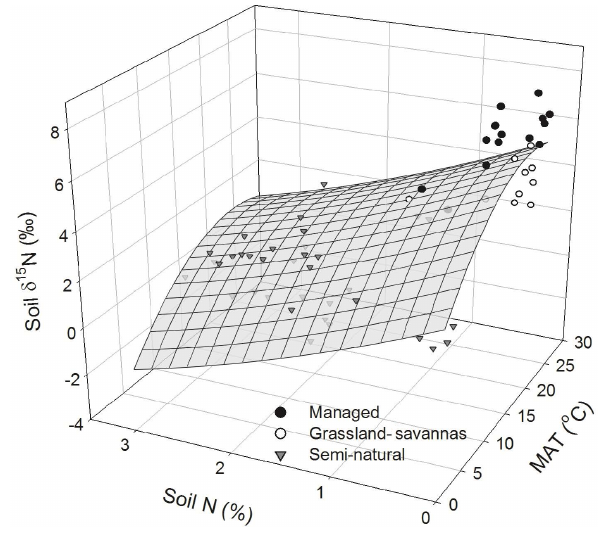
Figure 6. Measured and modelled soil δ 15 N values predicted as a function of soil N abundance and mean annual temperature (MAT). Data points are classified by generic land uses (i.e. in- tensively managed cropping sites, extensively managed grassland and savannas, and semi-natural ecosystems) observed along the el- evational and land-use gradient. The regression takes the follow- ing form: soil δ 15 N = 1 . 10 + 0 . 49 (MAT) − 1.86 (soil N) − 0.01 (MAT) 2 + 0 . 14 (soil N) 2 ; ( r 2 adj = 0 . 68, P < 0 . 05, n =